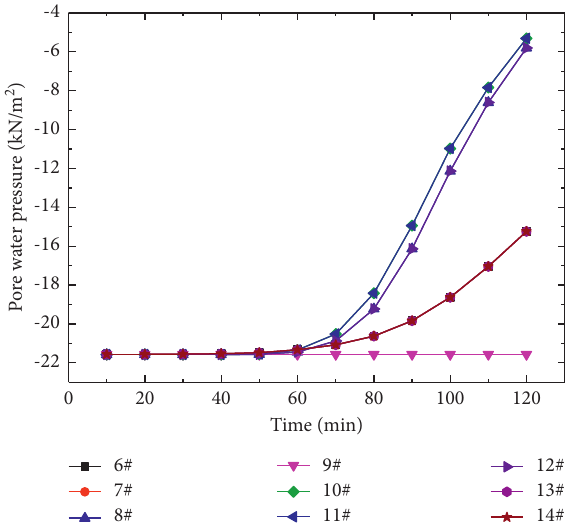
Figure 36: Pore water pressure of observation points 6–14 with seepage wells placed around buildings 1 and 2 in the numerical model.